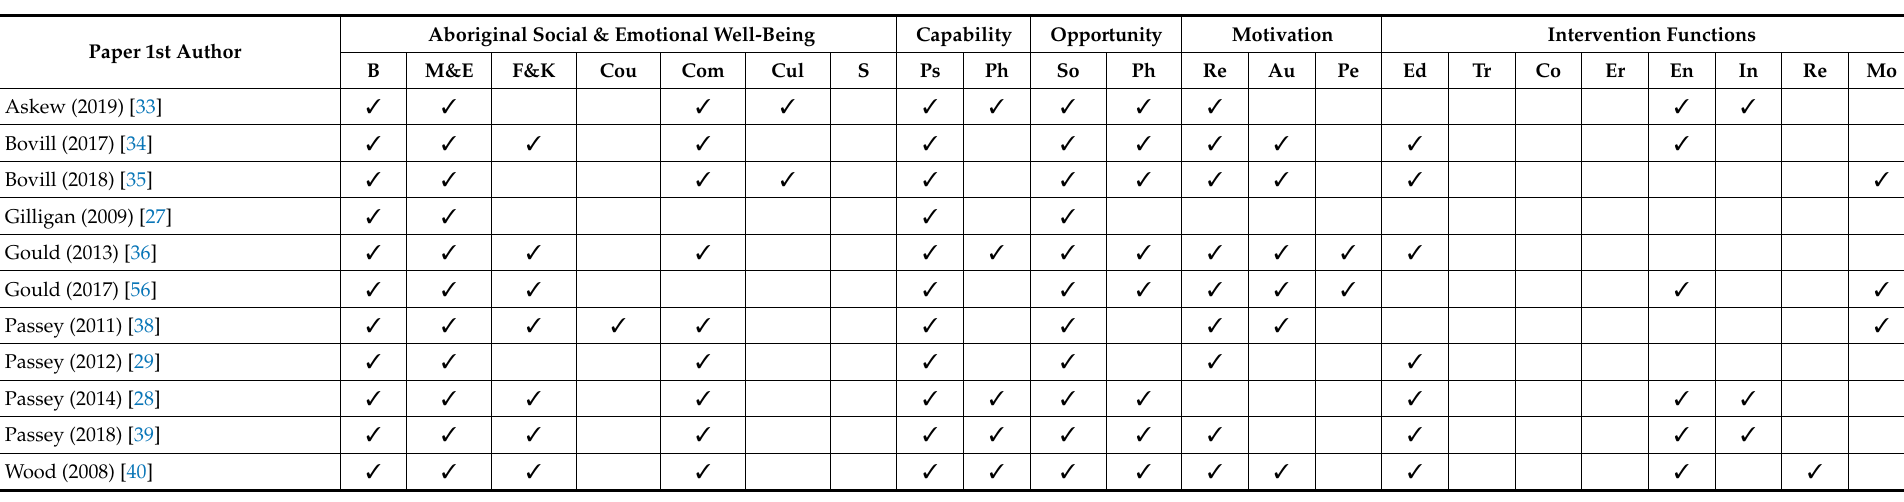
Table 4. Alignment of peer reviewed studies with the domains of Aboriginal Social and Emotional Wellbeing Model and Behavior Change